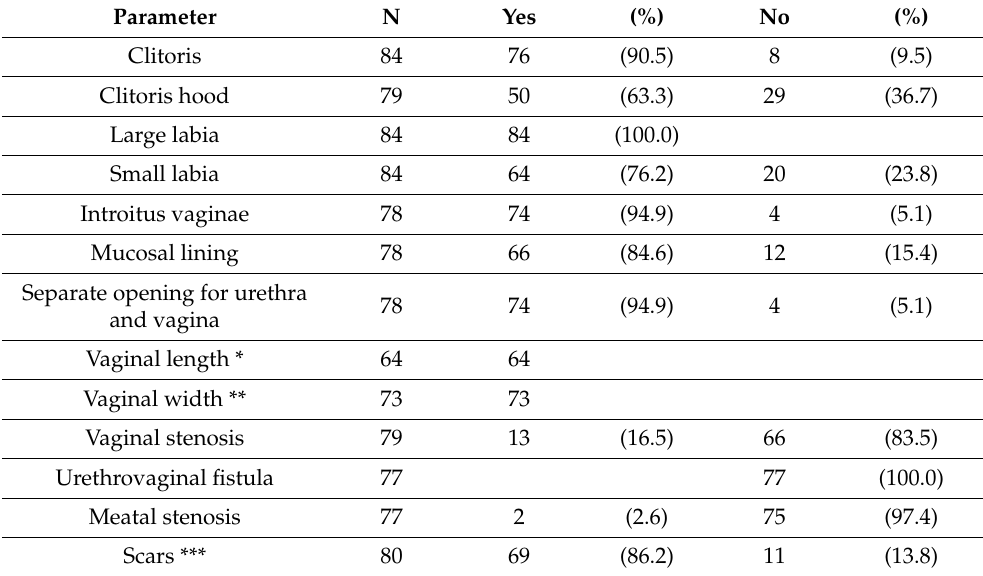
Table 3. Results of the gynecological examination in 84 women with